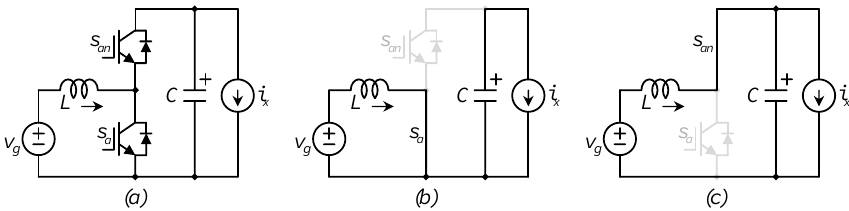
Figure 21. ( a ) The boost pre-regulators and their equivalent circuits according to the switching state, ( b ) when s a = 1 ( s an = 0), and ( c ) when s a = 0 ( s an = 1).